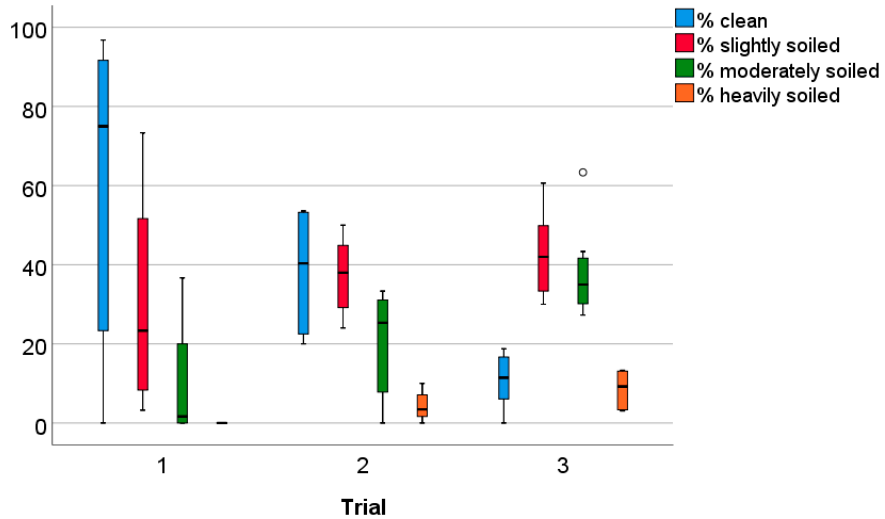
Figure 3. Soiling of animals (percentages of clean, slightly, moderately, or heavily soiled animals per